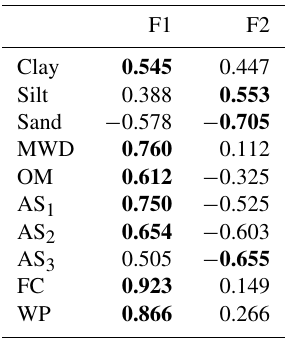
Table 3. Correlation matrix of investigated soil properties. Variables Clay Silt Sand OM MWD AS 1 AS 2 AS 3 FC Silt 0.414 Sand − 0.699 − 0.900 OM 0.056 − 0.005 − 0.034 MWD 0.651 0.152 − 0.437 0.458 AS 1 0.165 0.053 − 0.106 0.620 0.460 AS 2 0.097 − 0.062 0.015 0.550 0.402 0.871 AS 3 − 0.034 − 0.100 0.121 0.485 0.230 0.830 0.845 FC 0.517 0.409 − 0.556 0.604 0.757 0.548 0.456 0.298 WP 0.535 0.460 − 0.607 0.540